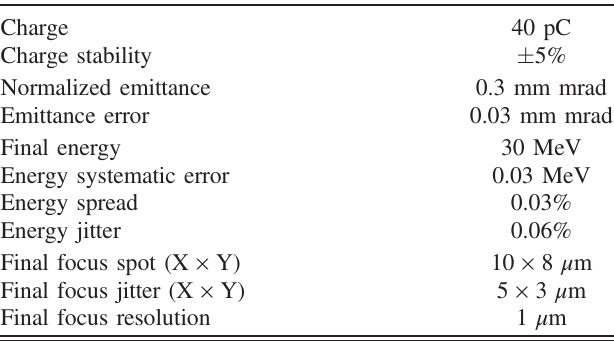
TABLE II. Summary of measured electron beam parameters.